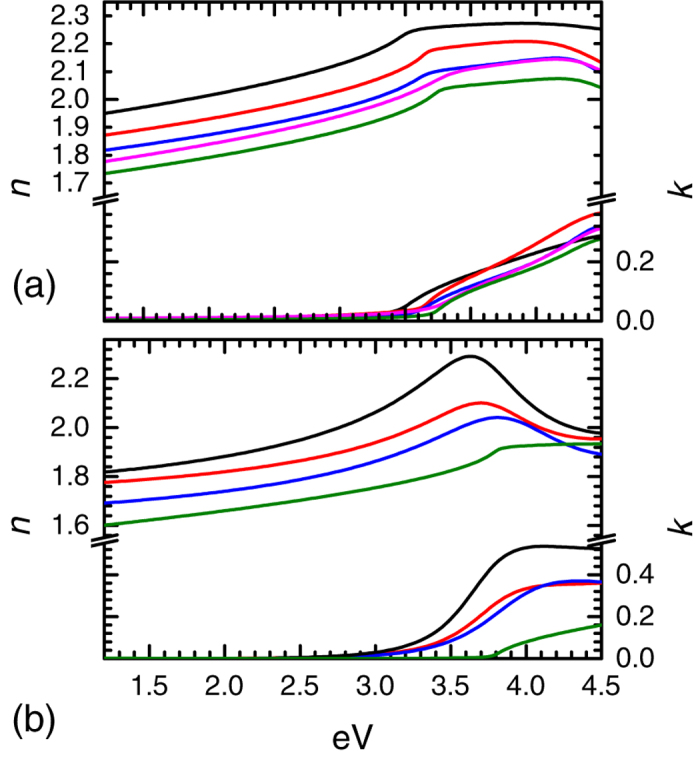
Refractive index of the superlattices.Dielectric functions of the (a) a-IGZO/SiOx and (b) ZnO:Al/SiOx superlattices. (–) bulk film, () 10/2.5 nm, () 10/5 nm, () 10/7.5 nm, () 10/10 nm.